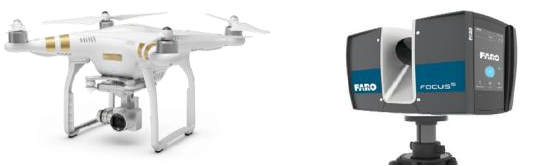
Figure 2 . Equipment used: Phantom 3 Professional and Faro Focus S350